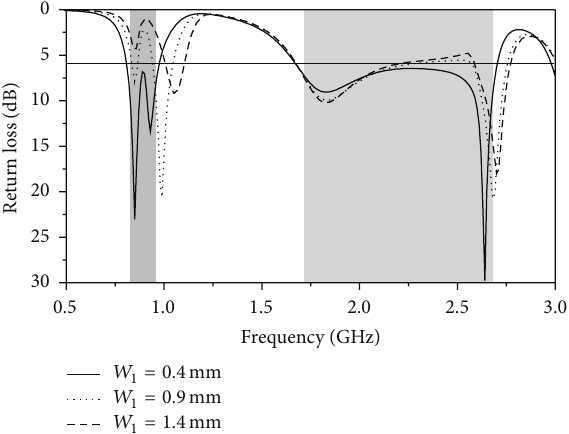
Figure 3: Return loss characteristics of the various shorted strip widths of MPIFA.